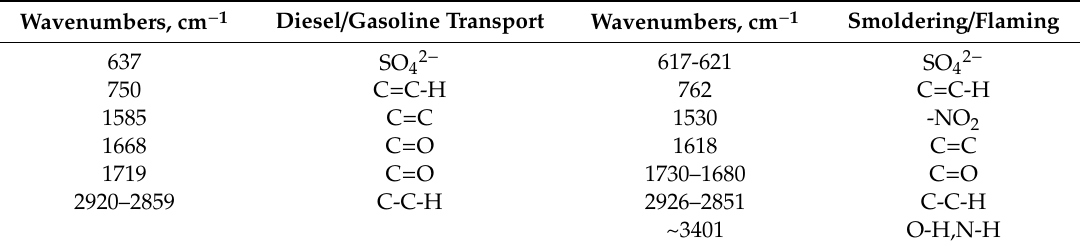
Table 1. Patterns of functional groups acting as functional markers of transport vehicle and regional BB smoldering and flaming emissions in Moscow